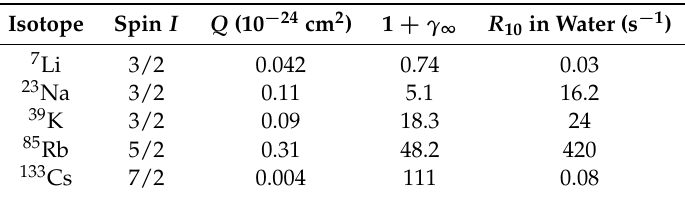
Table A1. Parameters monitoring the order of magnitude of the quadrupolar Hamiltonian of some alkali cations (see